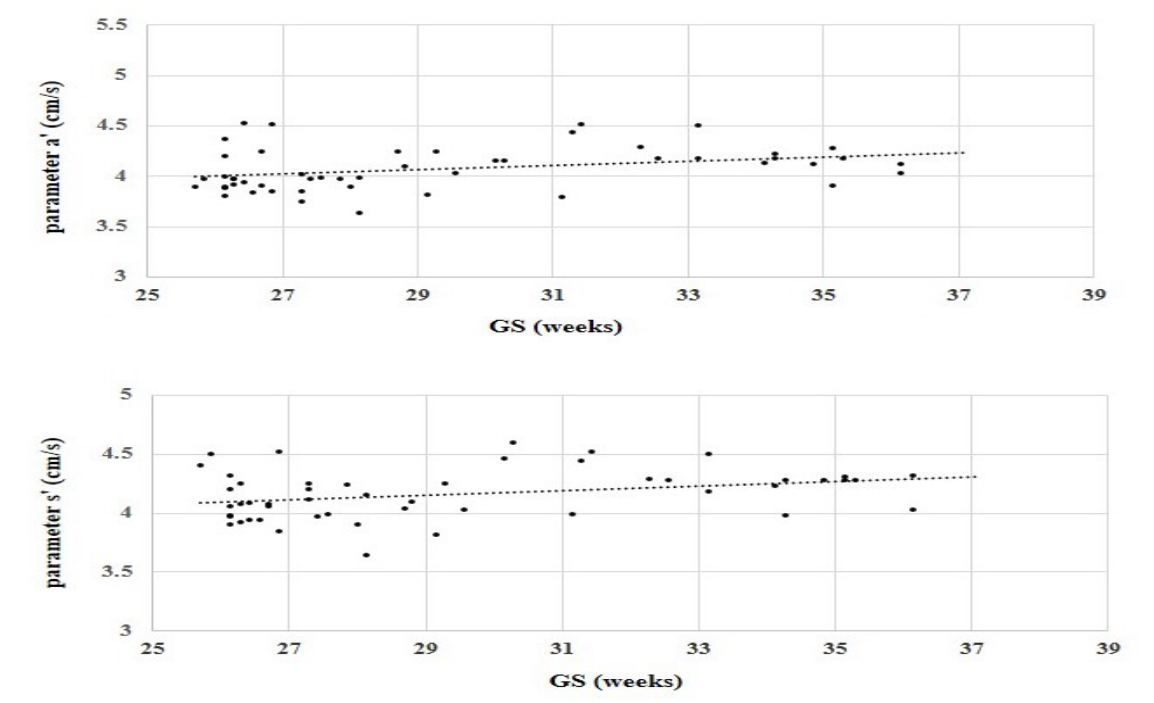
Figure 2. Correlation of parameters a’ and s’ with gestational age for all 50 subjects. Legend: GA— gestational age; parameter a’—maximum velocity of the mitral annulus in late diastole; parameter s’—maximum systolic velocity of the mitral annulus.